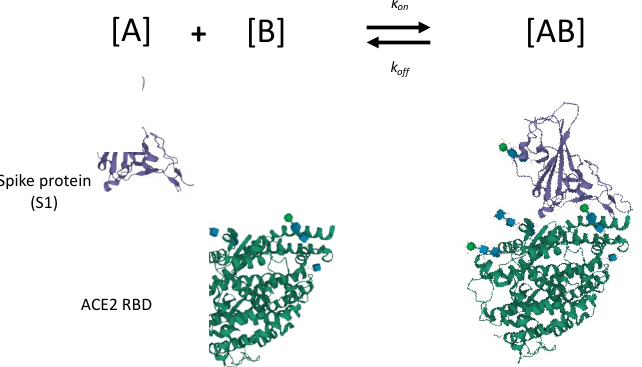
Figure 8. Schematic for binding of recombinant spike protein (subunit 1 core; recognition binding motif (RBM) not shown) and truncated ACE2 recognition binding domain (RBD). Each recombinant protein is truncated for experimental isolation of binding kinetics (e.g., enzymatic portion of ACE2 is cleaved). Most experimental studies focus on binding truncated ACE2 RBD with spike protein subunit 1 (shown here), and subunit 2, but few focus on inactivated SARS-CoV-2 virion. Crystal structures of spike protein subunit 1 and ACE2 are courtesy of Shang et al. [92]; program by Sehnal et al. [28] used for modification and export.